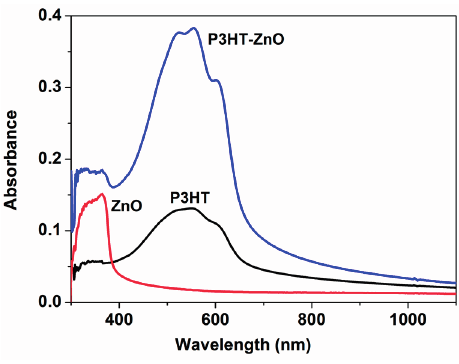
Figure 4. UV-Vis absorption spectra of P3HT, ZnO and P3HT-ZnO thin